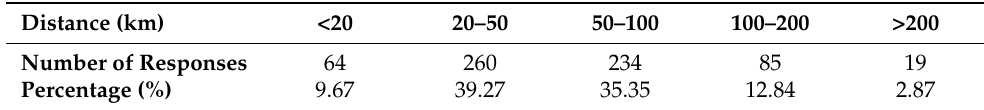
Table A1. Responses to Travel Distance